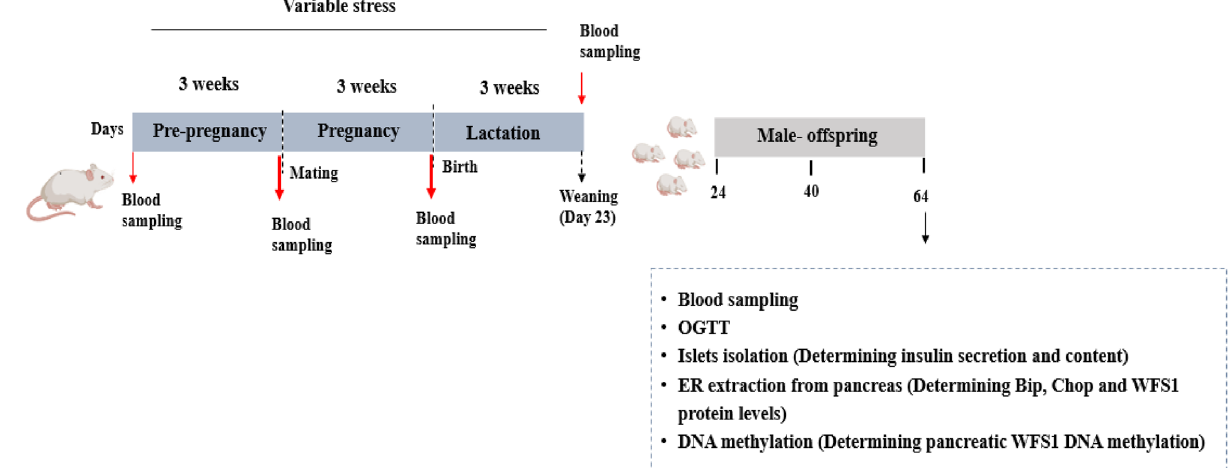
Figure 9. Experimental procedures over the course of the